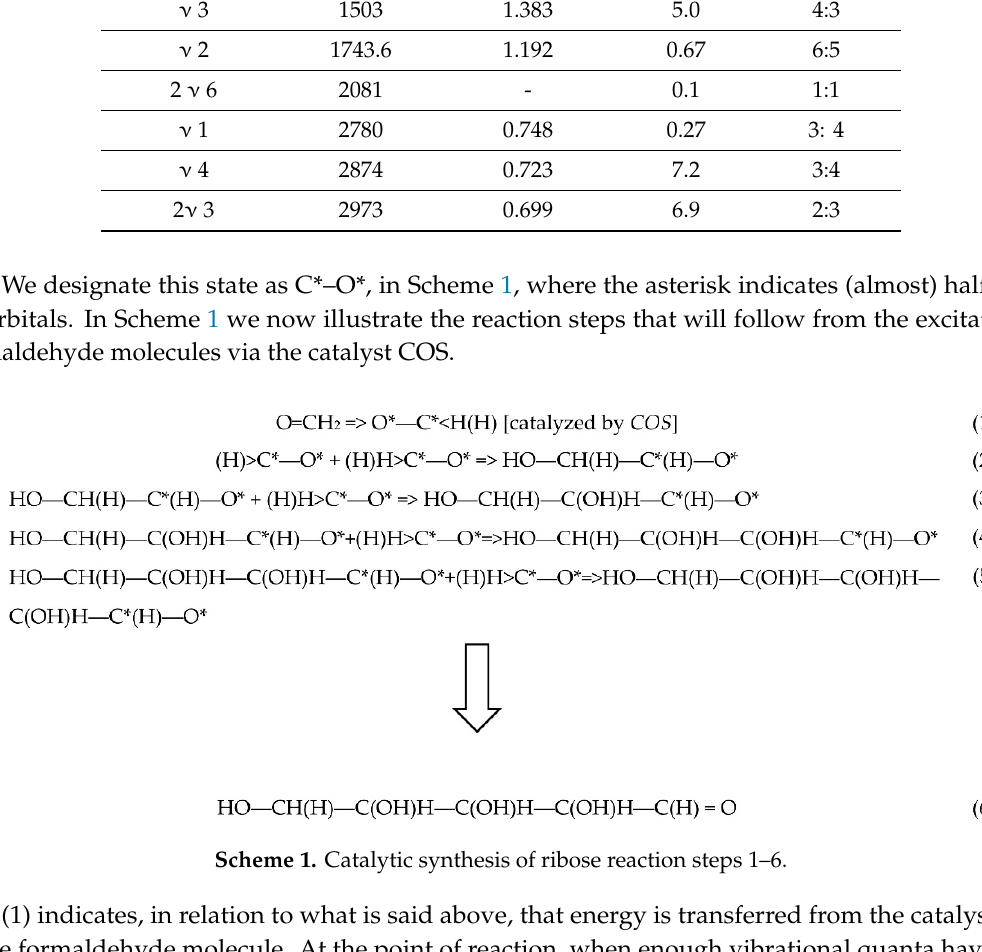
Table 1. Treatment of observed vibrations of H 2